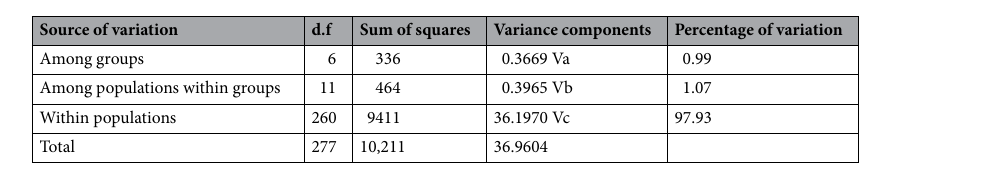
Table 2. Results of analysis of molecular variance (AMOVA).